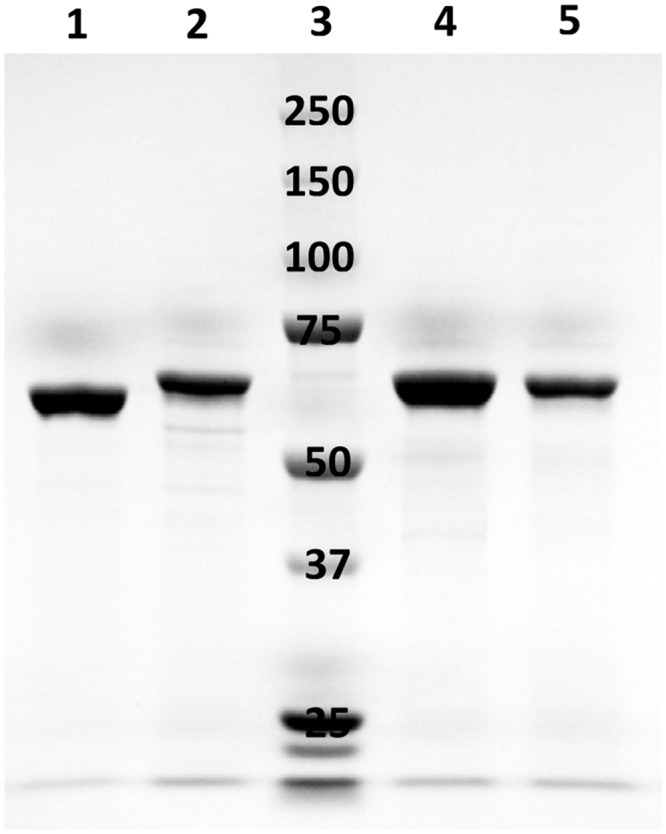
SDS-PAGE analysis of purified LAHs expressed from respective recombinant Escherichia coli BL21 (DE3) cells. Lane 1, LAH of Lactobacillus reuteri; lane 2, LAH of Lactobacillus plantarum; lane 3, molecular mass marker proteins (250, 150, 100, 75, 50, 37, and 25 kDa); lane 4, LAH of Lactobacillus hammesii; lane 5, LAH of Lactobacillus spicheri.